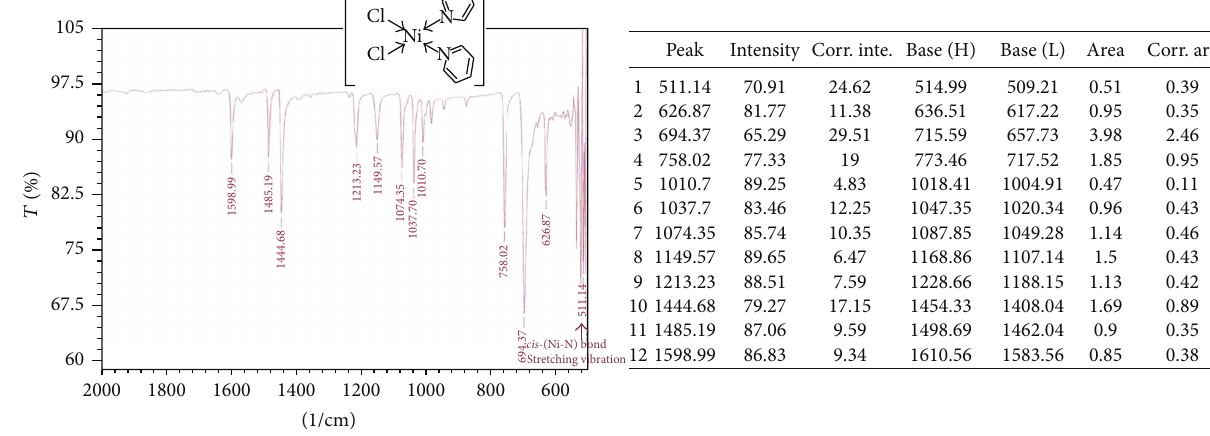
Figure 3: Infrared spectrum of cis -[Ni(C 5 H 5 N) 2 Cl 2 ].